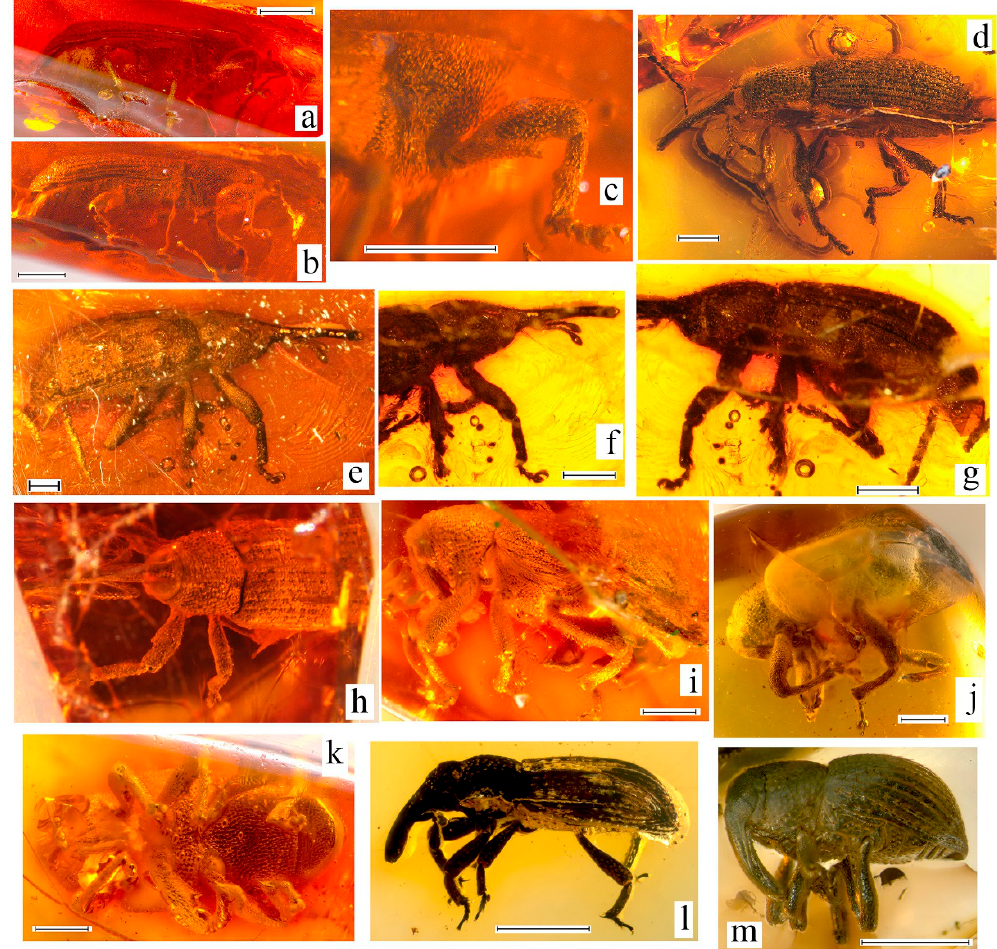
Figure 6. Habitus of Curculionidae from Baltic amber. ( a – c ) Electrotribus rarus sp. nov. , holotype, FEH , no. 651: body, ventrally ( a ); body, ventro-laterally ( b ); prothorax and foreleg, laterally ( c ). ( d ) Anchorthorrhinus incertus , holotype, GPIH , no. 199, body, laterally. ( e – g ) Isalcidodes macellus , holotype, GPIH , no. 200: body, laterally, on the right ( e ); fore-body, laterally, on the right ( f ); body, laterally, on the left ( g ). ( h ) Electrotribus theryi , holotype, CCMCL , no. A6487, dorsally. ( i – k ) Electrorhinus friedhelmi gen. et sp. nov. , holotype, FEH , no. 653, body, laterally ( i ); body, ventrally ( k ). ( j ) E. friedhelmi gen. et sp. nov. , paratype, ISEA , no. BA2019 / 1, laterally. ( l ) Palaeodexipeus kirejtshuki , holotype, ISEA , no. BA2015 / 3, body, laterally. ( m ) Leiosoma klebsi , holotype, ISEA , no. BA2013 / 3, laterally. Scale bars: 1.0 mm. See Section 2 for names of collections.